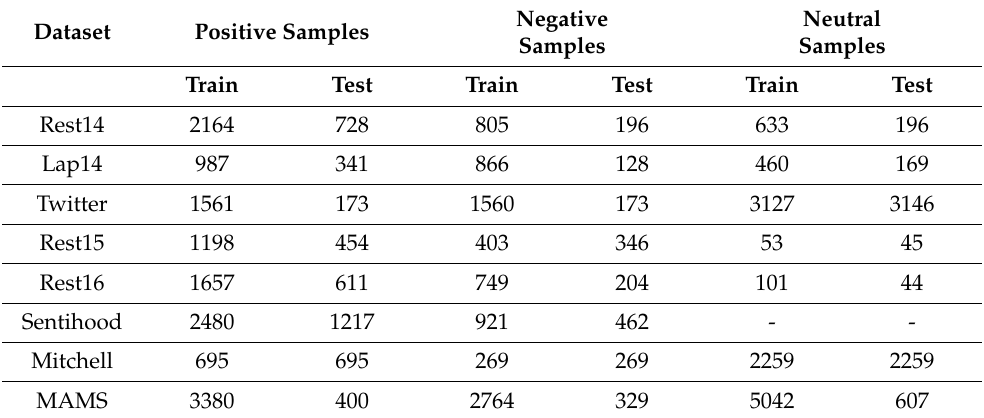
Table 2. Characteristics of the